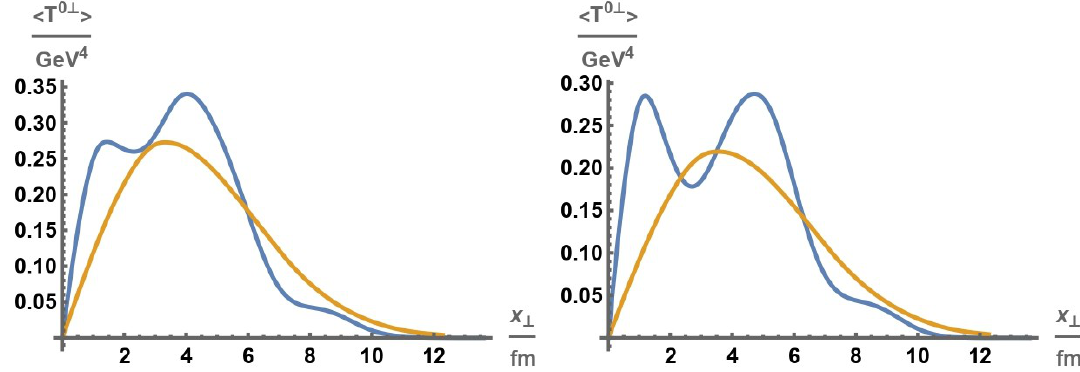
Figure 4 . The transverse plane angle-averaged transverse momentum density h T 0 ⊥ i ≡ h T 0 i (ˆ x ⊥ ) i i at rapidities ξ = 0 (left) and ξ = 0 . 5 (right), and at proper time τ = 0 . 1 fm/ c . The blue curve corresponds to the results obtained in this work, starting from initial conditions (2.1) with left and right moving shocks given by (2.8). The yellow curves are obtained from extrapolating results in [1] using the fact that the difference between a first order in transverse derivative approximation and exact results for aspect ratios corresponding to those of Lorentz contracted projectiles at RHIC are small ( < 10% )